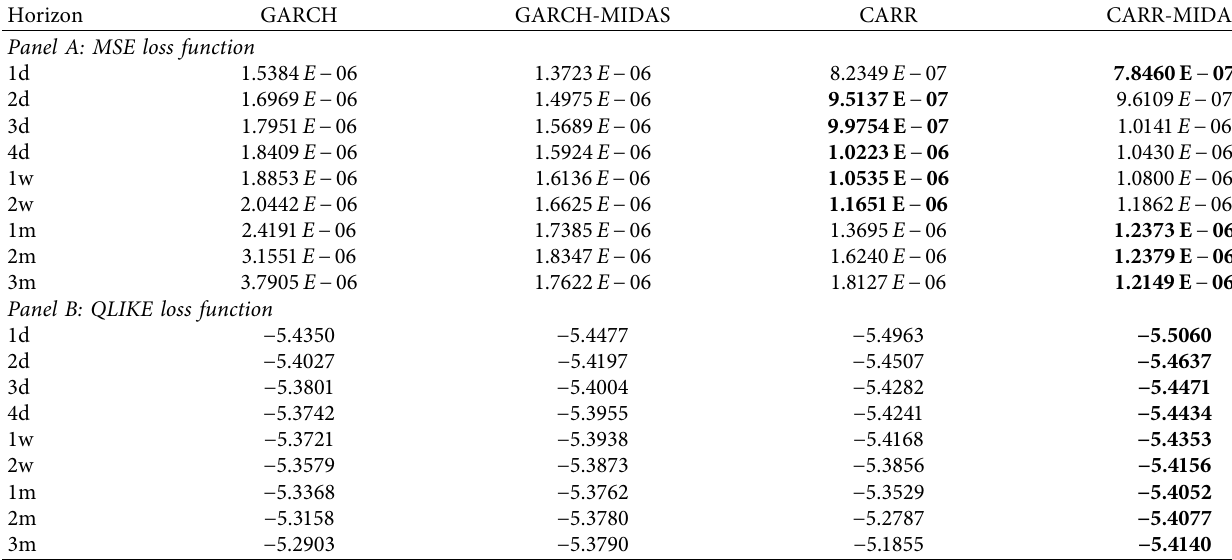
Table 7: Out-of-sample forecast evaluation results for forecast window of 1,500.